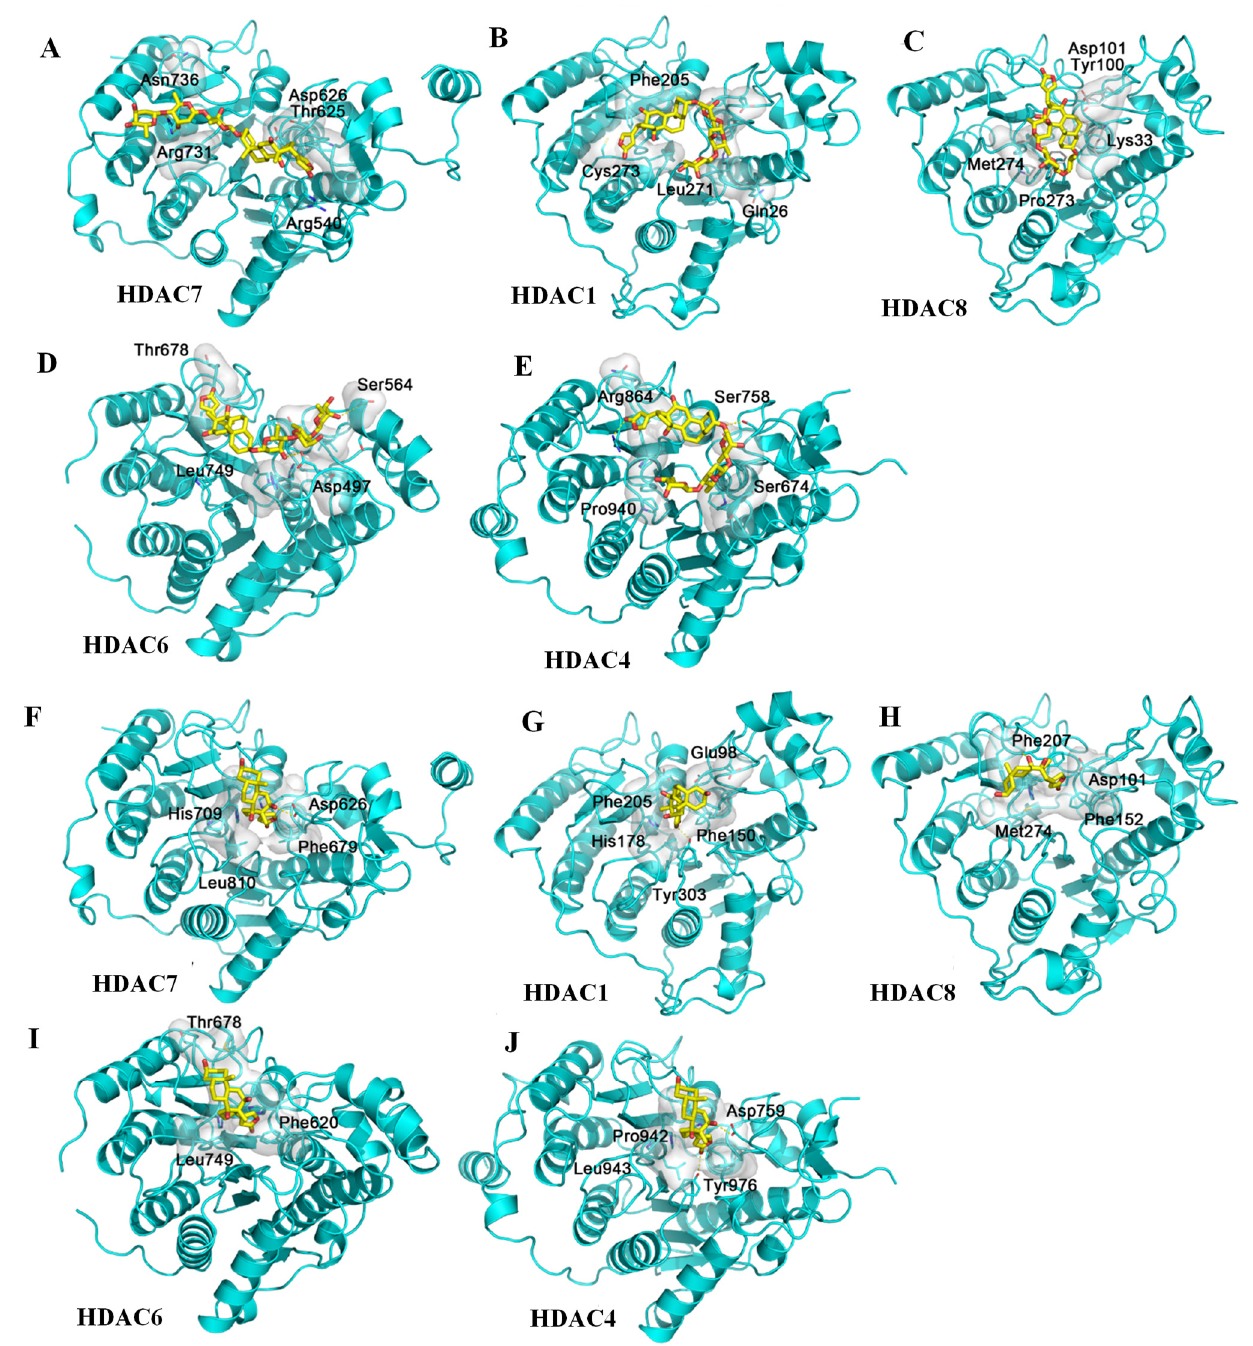
Figure 5. Docking profiles for digoxin (yellow) and histone deacetylases HDAC7 ( A ), HDAC1 ( B ), HDAC8 ( C ), HDAC6 ( D ), and HDAC4 ( E ); and digoxigenin (yellow) and HDAC7 ( F ), HDAC1 ( G ), HDAC8 ( H ), HDAC6 ( I ), and HDAC4 ( J ). The HDAC family has three classes and over 10 members in humans, but the structures of these proteins are notably similar, with the same binding site being at the center of each HDAC domain. Five crystal structures of different HDACs were obtained as the receptors for the docking of digoxin and digoxigenin. The center pocket of HDACs is too small for the steroid motif and the lactone unit of digoxin to be inserted, and thus, digoxin could not bind to HDACs ( A – E ), even though two different sizes of docking boxes were used to carry out docking. However, the docking profiles for digoxigenin and HDACs are greatly improved ( F – J ) when compared with those for digoxin.